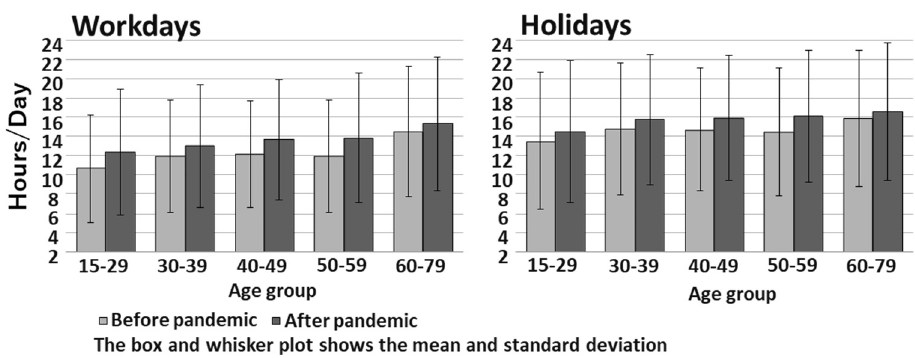
Figure 4. Change in average time spent at home during the coronavirus pandemic, by age group.